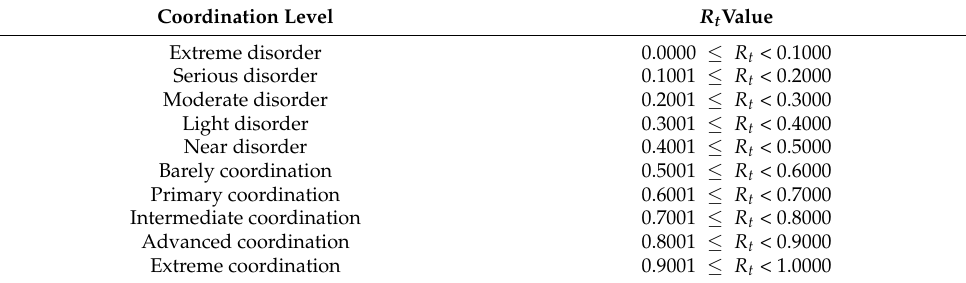
Table 1. Classification of coordination degree.